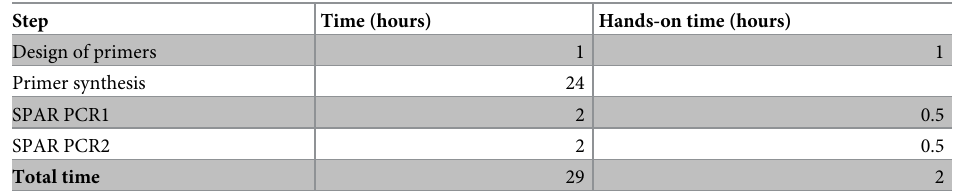
Table 2. Time requirements for Selective PCR for Antibody Retrieval